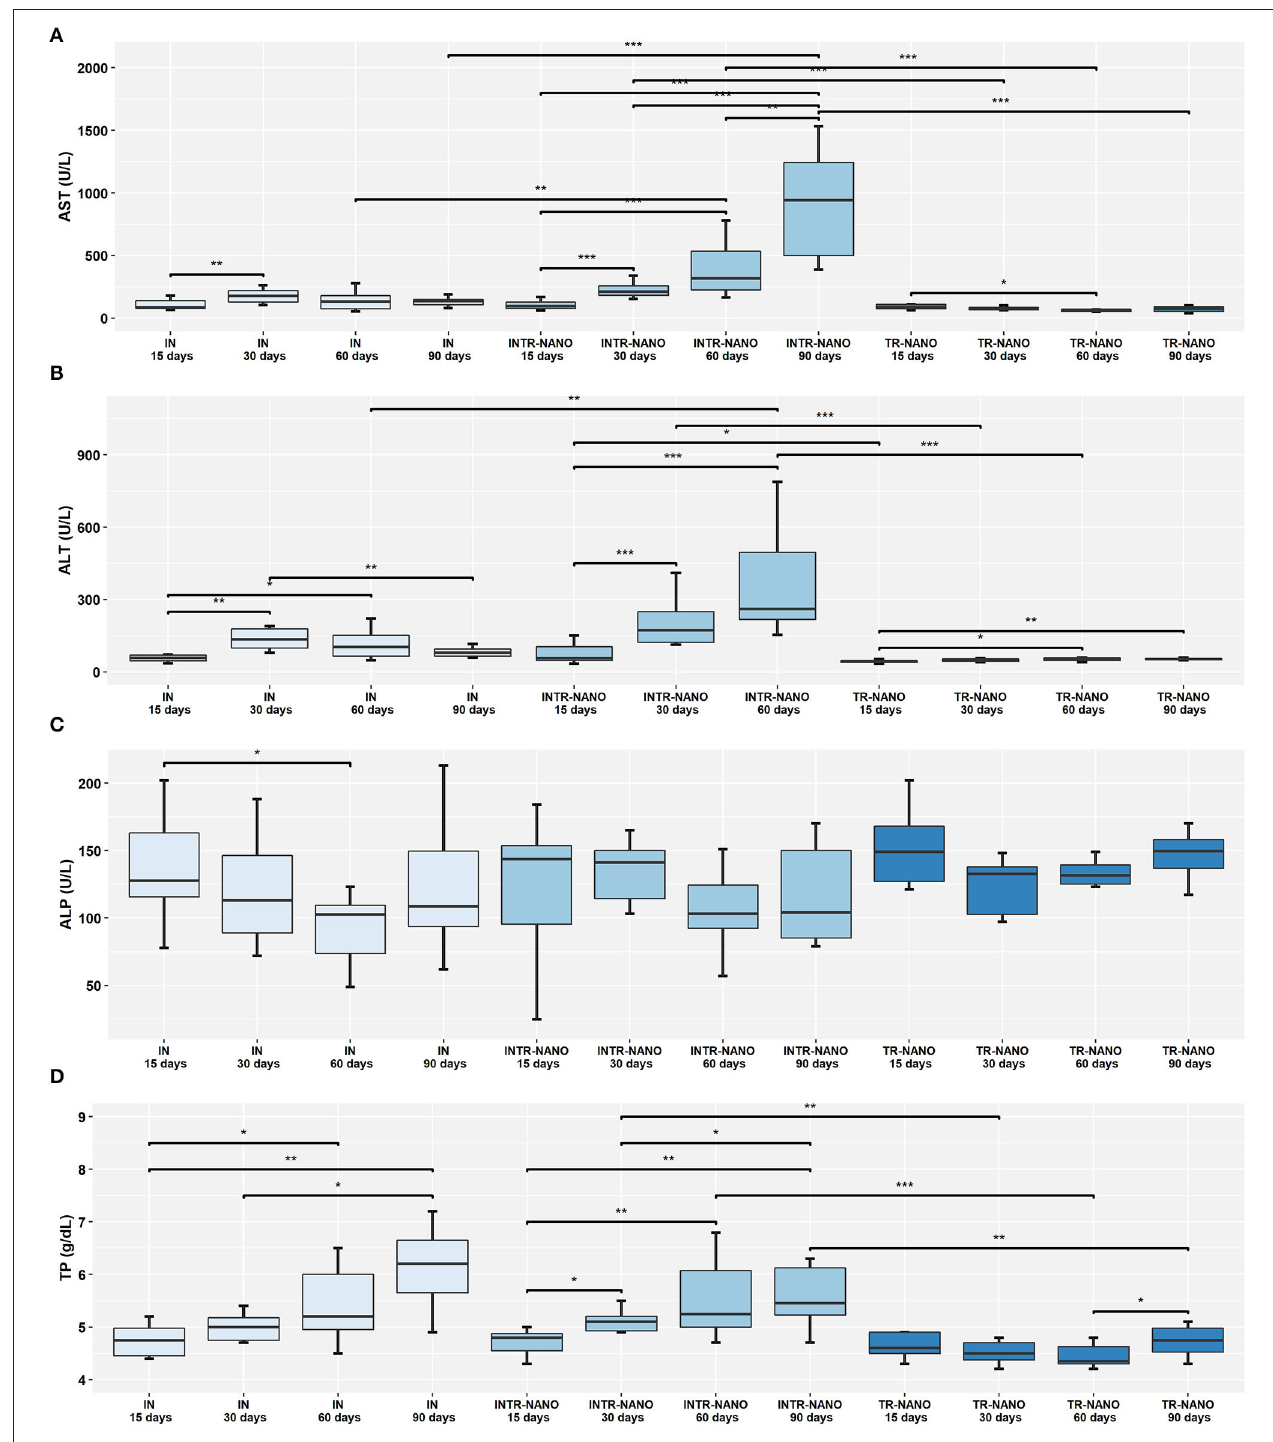
FIGURE 3 | Comparison of the results of serological parameters between the IN, INTR-NANO, and TR-NANO groups. (A) AST, Aspartate Transaminase; (B) ALT, Alanine Transaminase; (C) ALP, Alkaline Phosphatase; and (D) TP, Total Proteins. Mann-Whitney-Wilcoxon test: * P < 0.05, ** P < 0.01, *** P < 0.001.